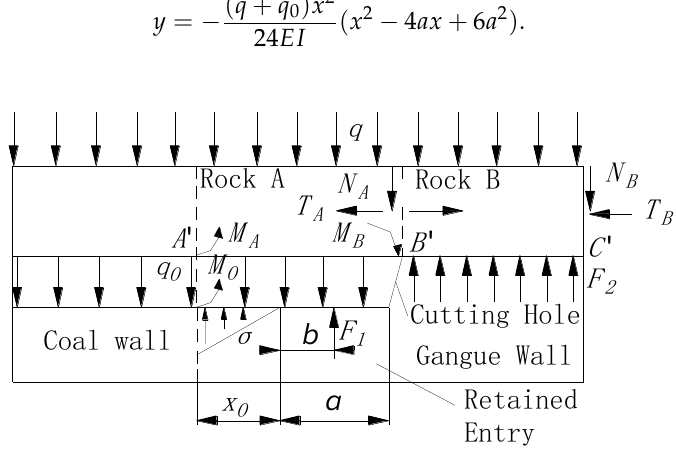
Figure 18. Simplified mechanical model of dynamic pressure and stable entry areas .